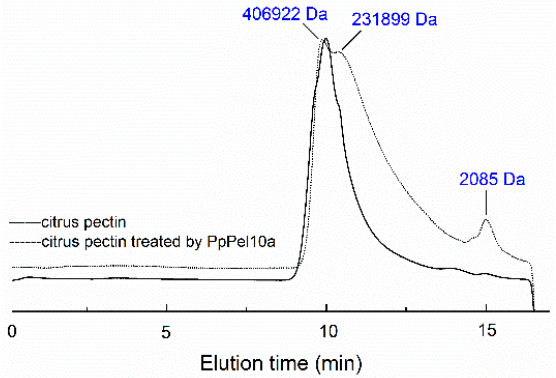
Figure 6. High-performance gel permeation chromatography analysis of the lytic products of citrus pectin produced by PpPel10a. (—) Citrus pectin; (-----) lytic products of citrus pectin.